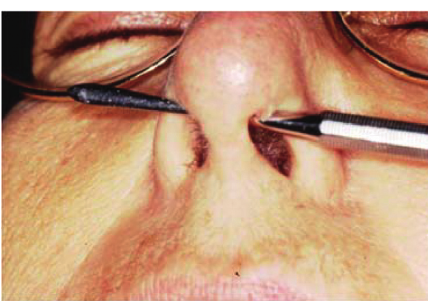
Figure 2: Nasal septum perforation.